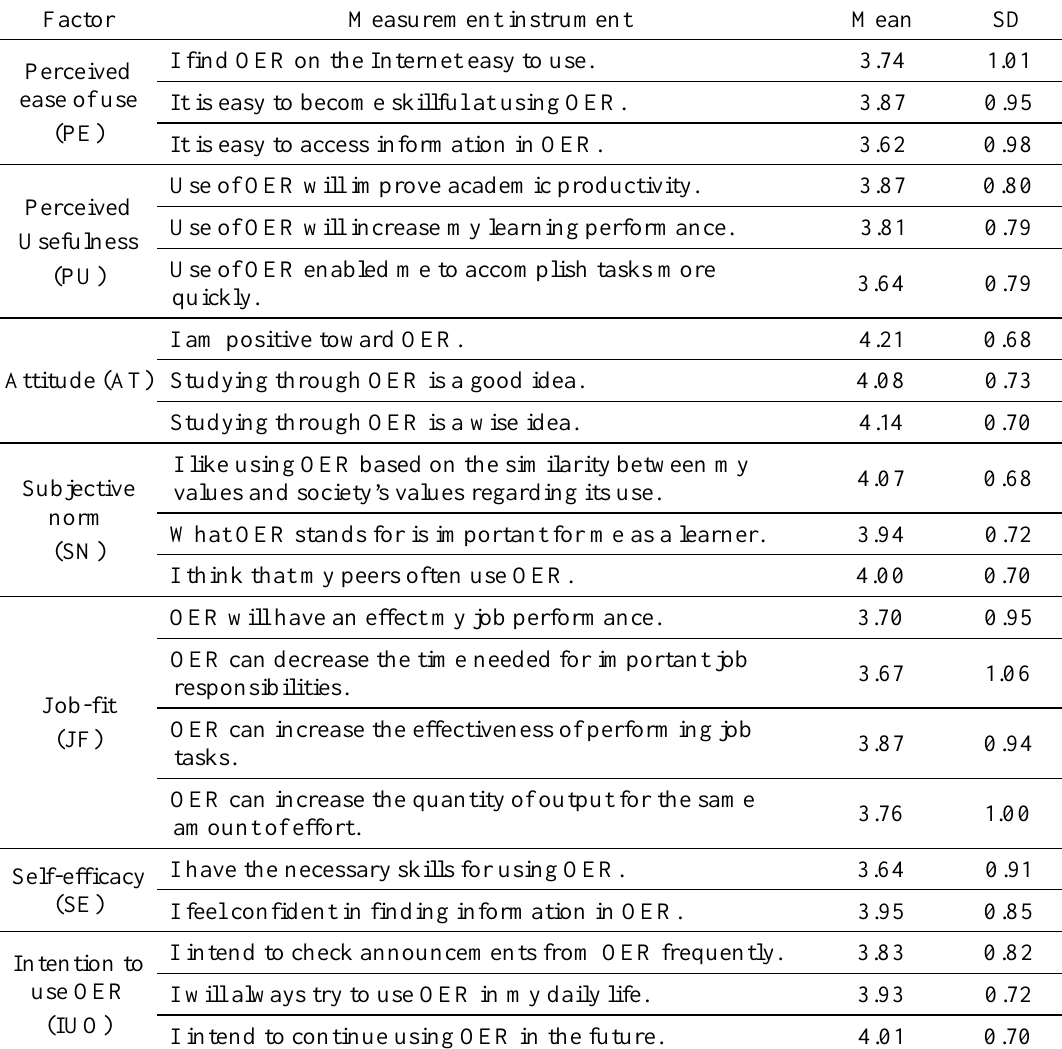
Table 2 Descriptive Statistics of Factors Affecting Intent to Use